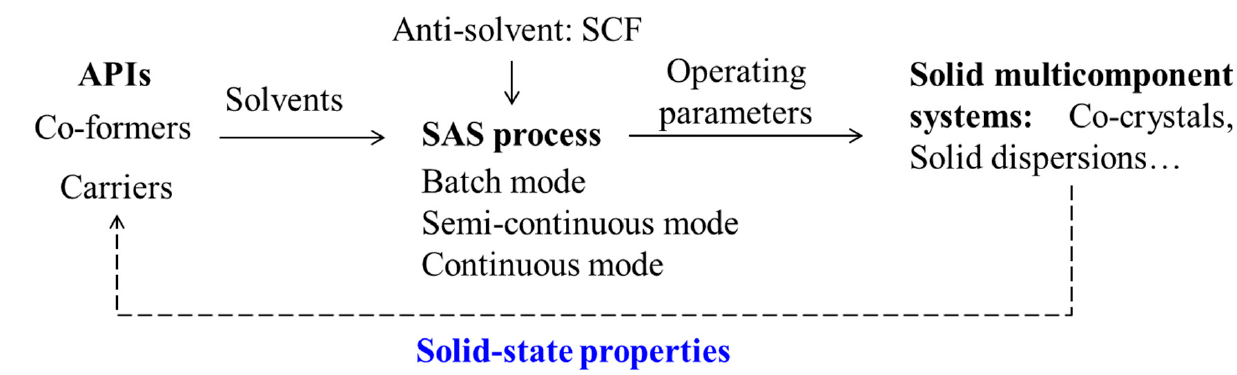
Figure 1. An overview of the SAS applications for solid multicomponent systems.